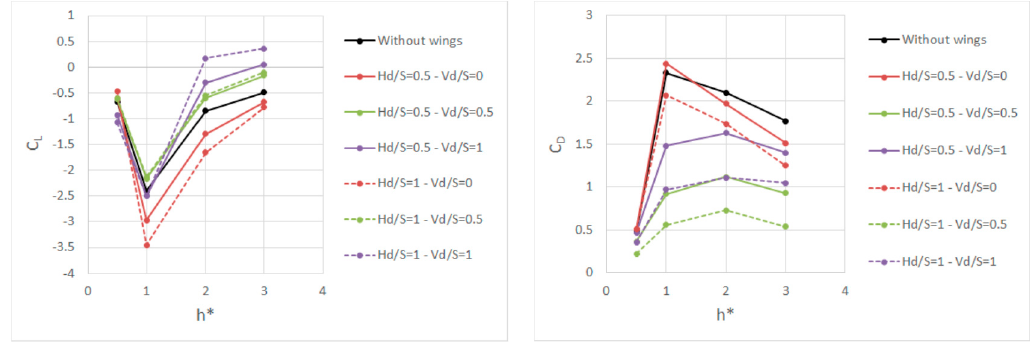
Figure 27. ( Left ) Lift coefficient versus h* for six different end caps. (Pr = 3, Fr = 0.3). ( Right ) Drag coefficient versus h* for six different end caps. (Pr = 3, Fr = 0.3).